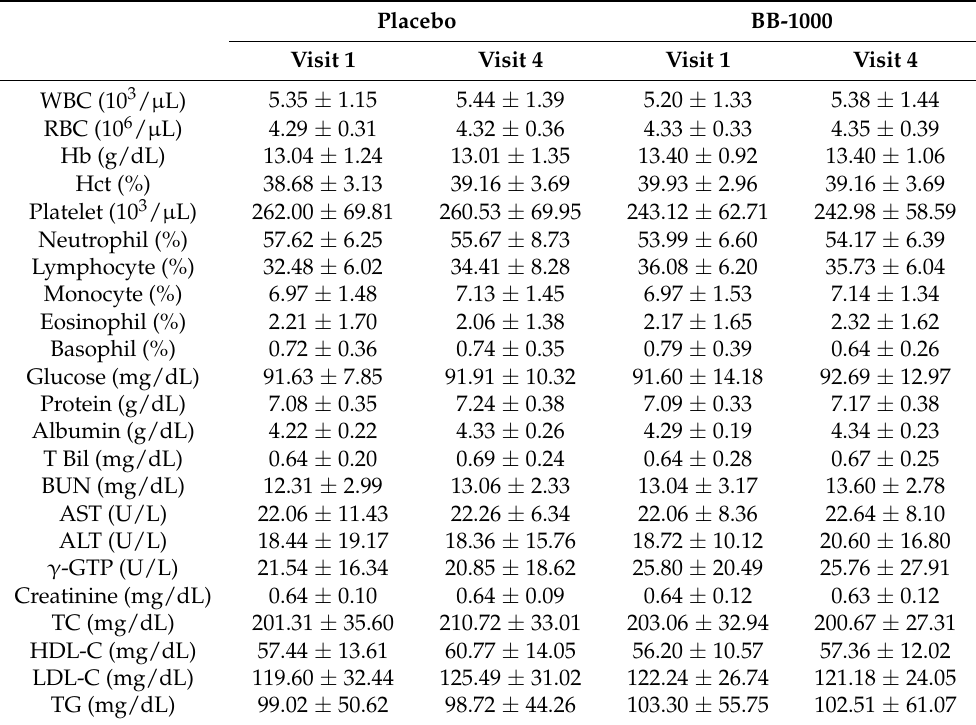
Table 3. Results of hematology and biochemical analysis in placebo and BB-1000